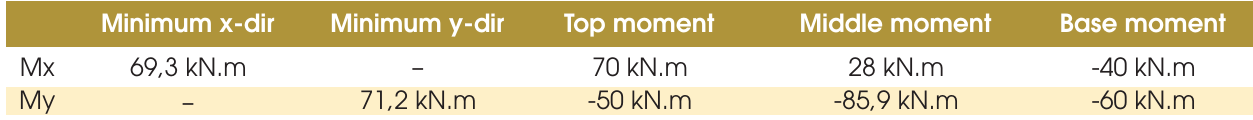
Table 2 – Design forces for the